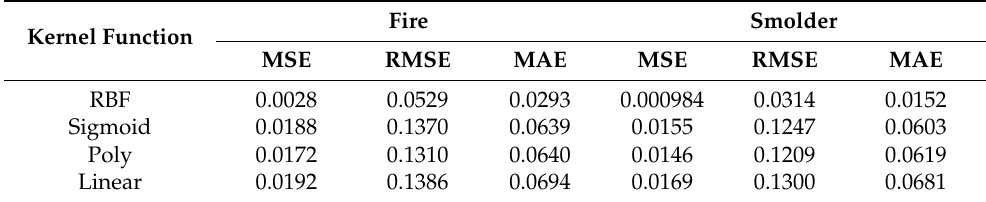
Table 5. The output error analysis.